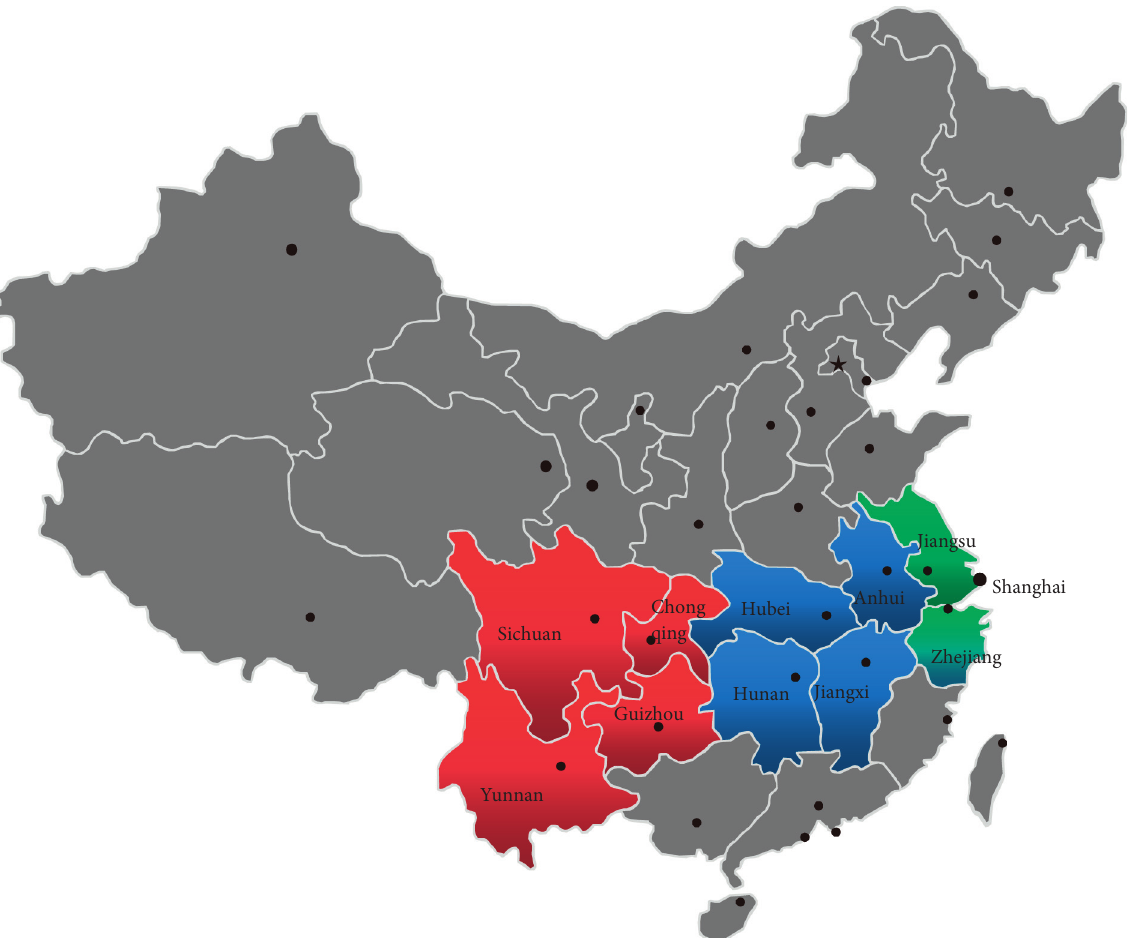
Figure 1: Geographical locations of the provinces and cities in the Yangtze River Economic